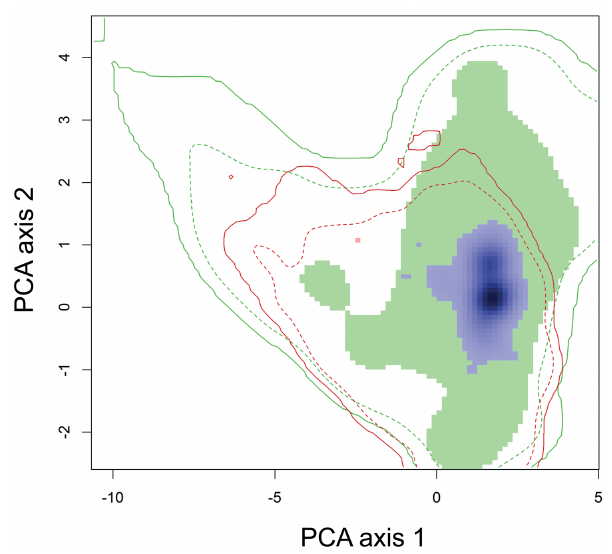
Figure 2 – Principal component analysis (PCA) comparing climatic envelopes associated with data of presence (blue area) and absence (red area) of Peruvian peppertrees in Mexico. Contour lines indicate 100% (solid lines) and 75% (dashed lines) of the climatic environment covered by sites where the species is present (green lines) or absent (red